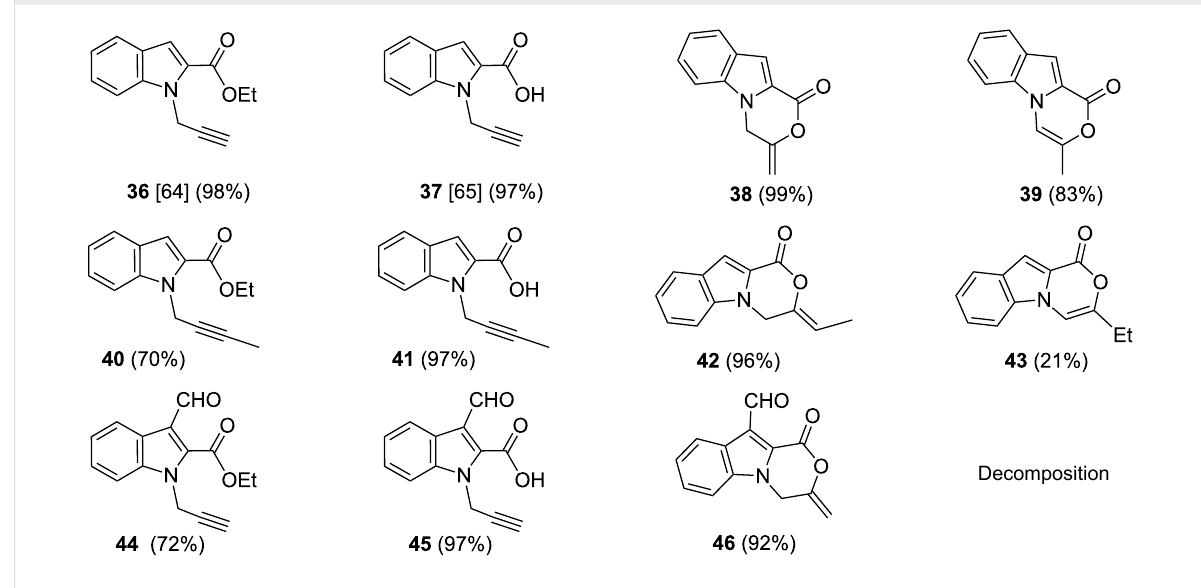
the cyclization products were reacted with trifloroacetic acid (TFA) to form endo -cyclic double bonds. Some of the com- pounds underwent double bond shifts to form an oxazinone skeleton 19 , 23 , 27 , 39 and 43 , whereas the compounds 30 and 34 did not form the corresponding endo -cyclic systems 31 and 35 . In order to address this question, we carried out some DFT calculations